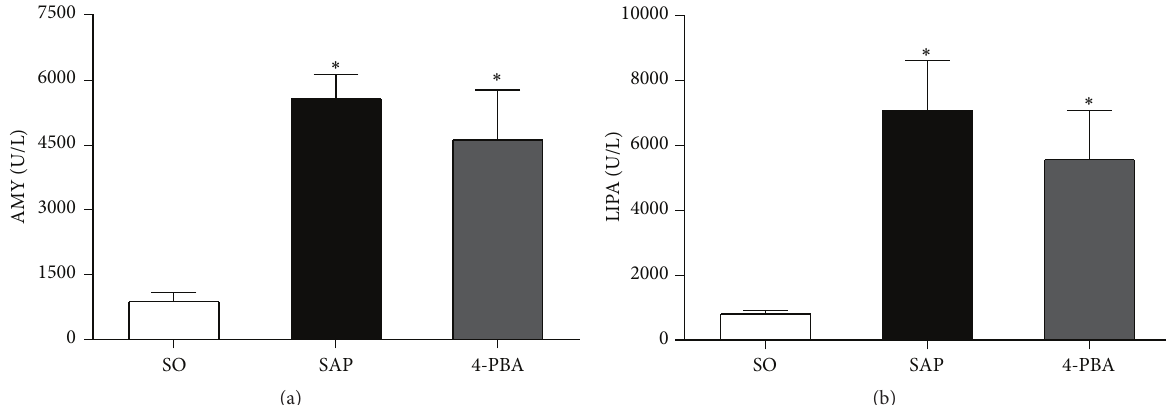
Figure 1: Serum levels of AMY, LIPA in all groups of rats. Each value represents the mean ± standard deviation. ∗ 𝑃 < 0.05 versus SO group.